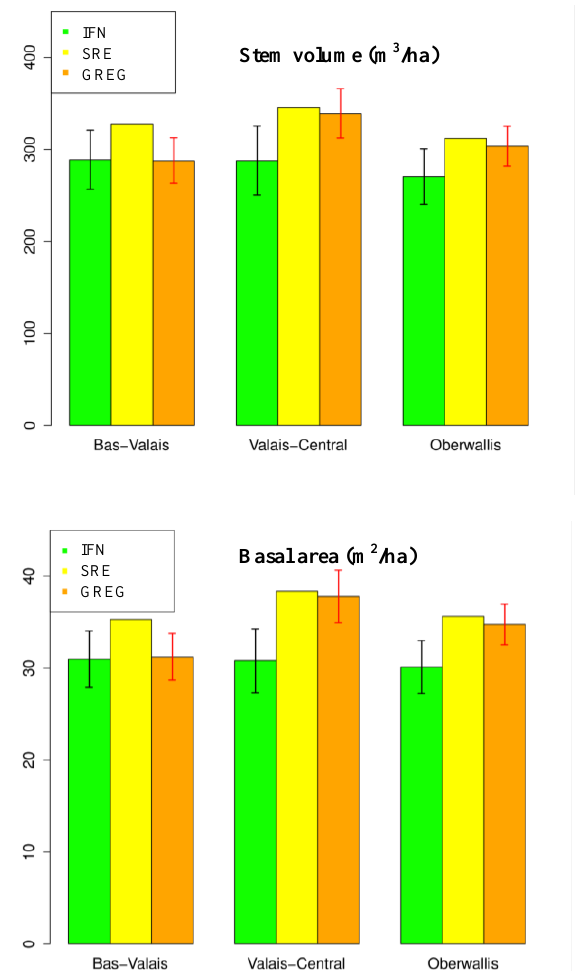
Figure 3. Mean volume and basal area for each